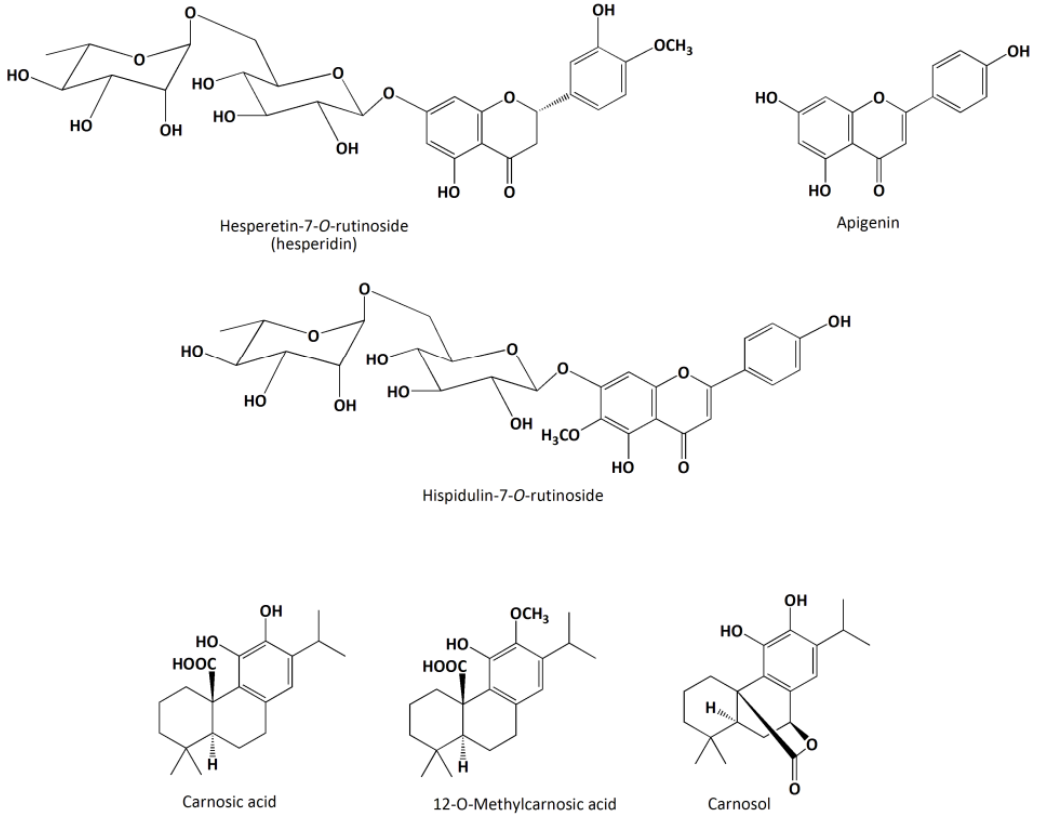
Figure 2. Some of the (poly)phenolic compounds present in the rosemary extract.